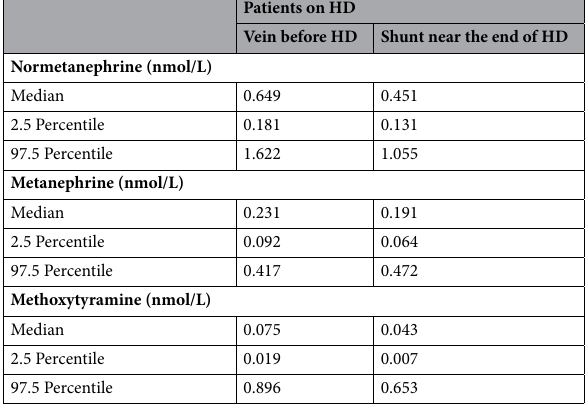
Table 2. HD specific cut-offs (97.5% percentiles) for plasma metanephrines for patients on HD when the blood is drawn from the vein and before HD versus the shunt, near the end of